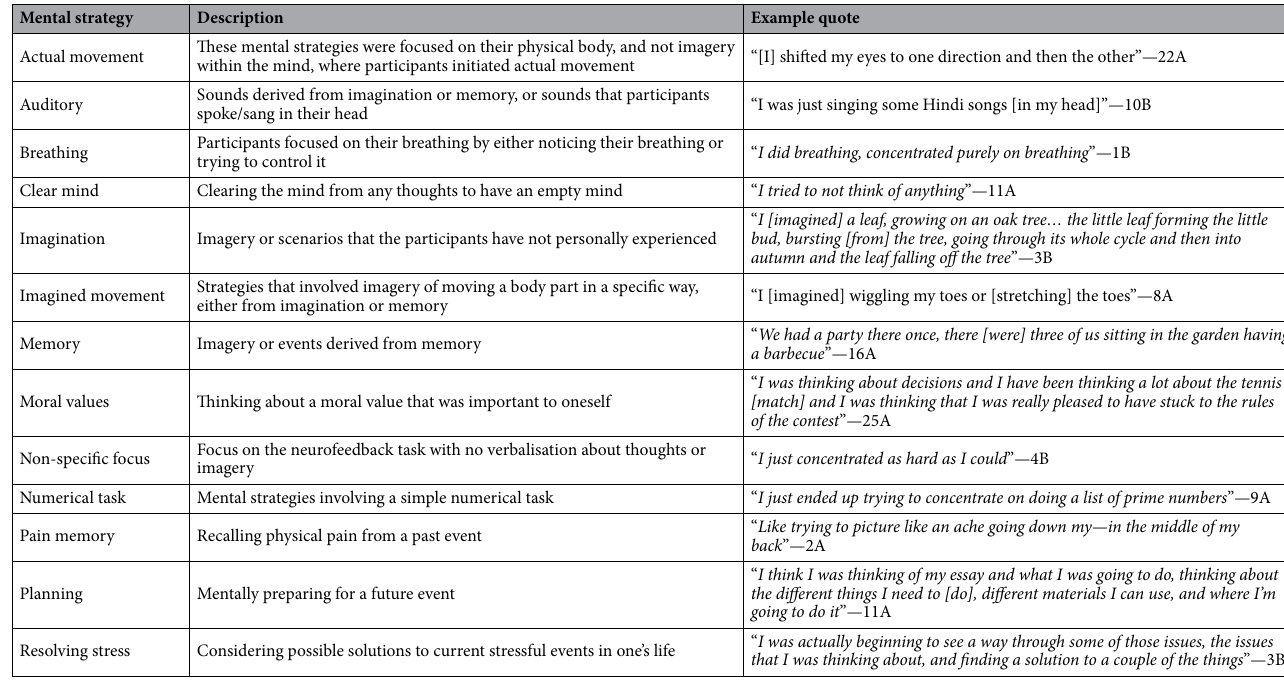
Table 3. List of the mental strategies identified and their descriptions. “A” and “B” denotes non-CNP and CNP participants